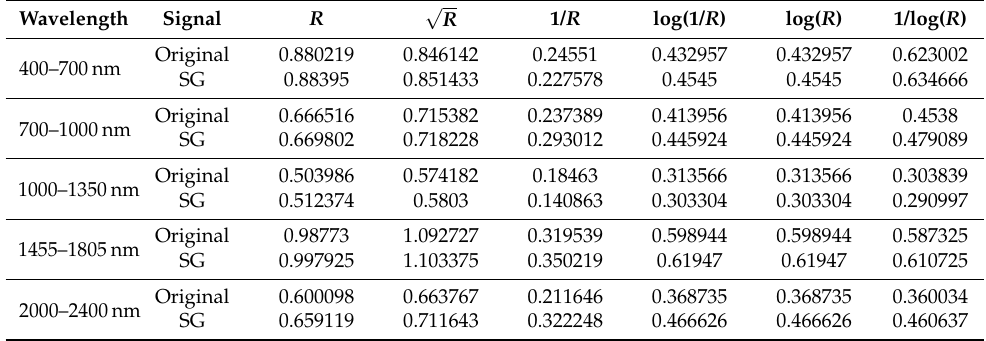
Table 1. The root mean square error (RMSE) value of the probability neural network (PNN) model in Area A.